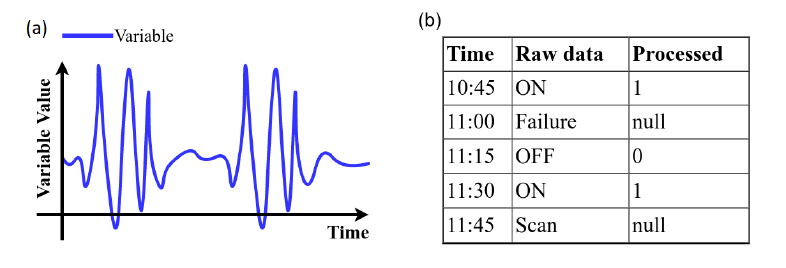
Figure 9. Data cleansing process rules: ( a ) variables with high variance and ( b )